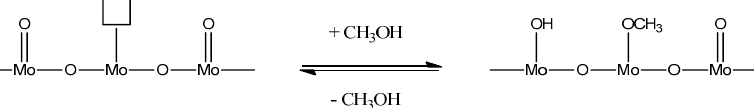
Figure 15. Dissociative chemisorption of methanol on α‐ MoO 3 [49]. The dual acid ‐ base sites are